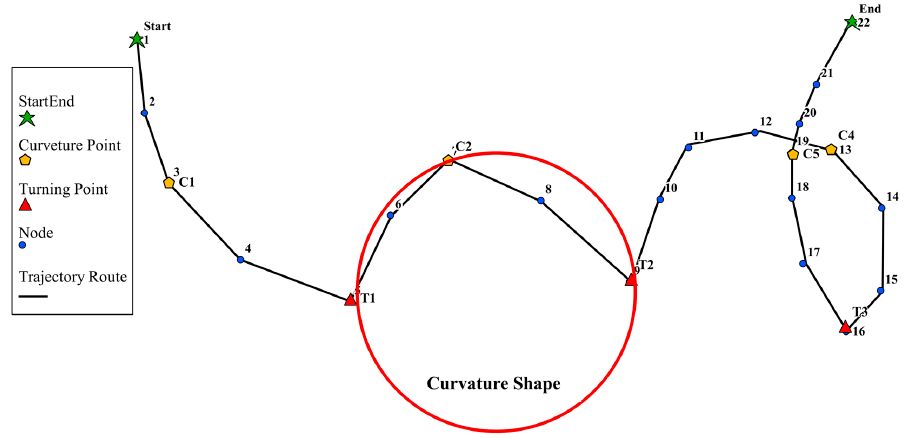
Figure 3. A trajectory with curvature, turning and self-intersection points.